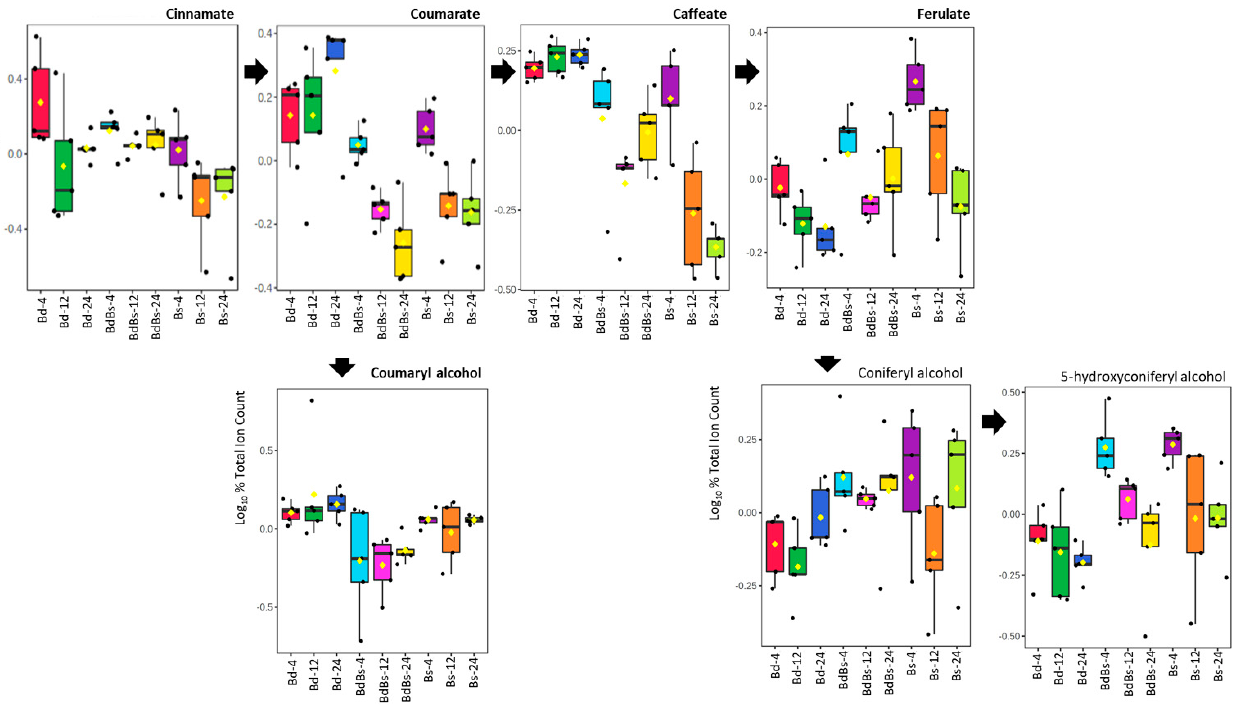
Figure 9. Monolignol metabolites, which are significant sources of variation, in Brachypodium endosperm during germination. Data show box and whisker comparison of B. distachyon Bd21 (Bd), B. stacei ABR114 (Bs), and B. hybridum ABR113 (BdBs) at 4, 12, and 24 HAI. The arrangement of the plots reflect the associated between the metabolites, as indicated in https://www.genome.jp/kegg-bin/show_module?M00039 (accessed on 28 February 2021).